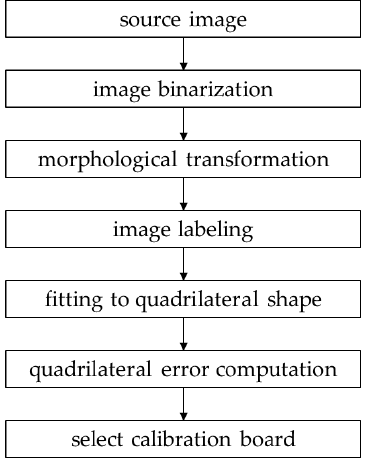
Figure 7. The procedure for calibration board detection.